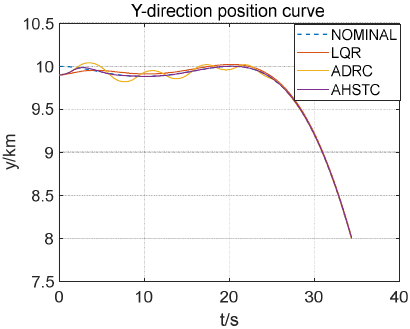
Figure 5. Height y tracking curve.